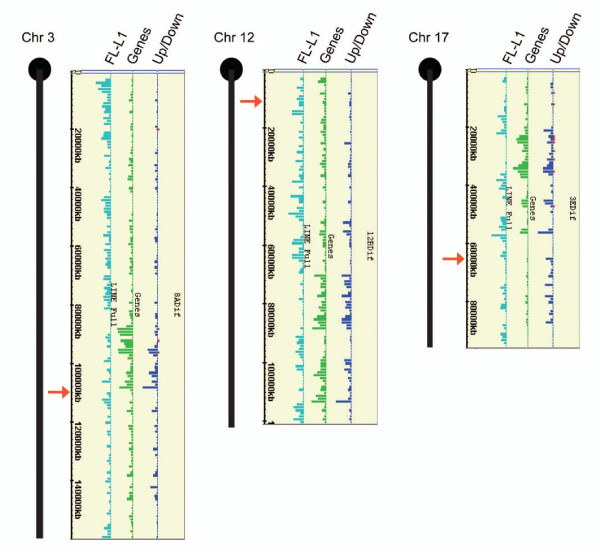
Silencing propagates along the length of iXist transgene expressing autosomes. The figure illustrates at 1 Mb resolution the distribution of downregulated (dark blue bars) and upregulated (red bars) genes on the transgene-bearing chromosomes for cell lines 8A, 12B and 3E, respectively. The height of the bar indicates the frequency of genes per Mb (maximum height in the different cell lines corresponds to 12-14 genes/Mb). Tracks showing the frequency of genes (green), and, full-length L1 elements (light blue), are also shown. The approximate position of the transgene integration site is indicated with a red arrow.